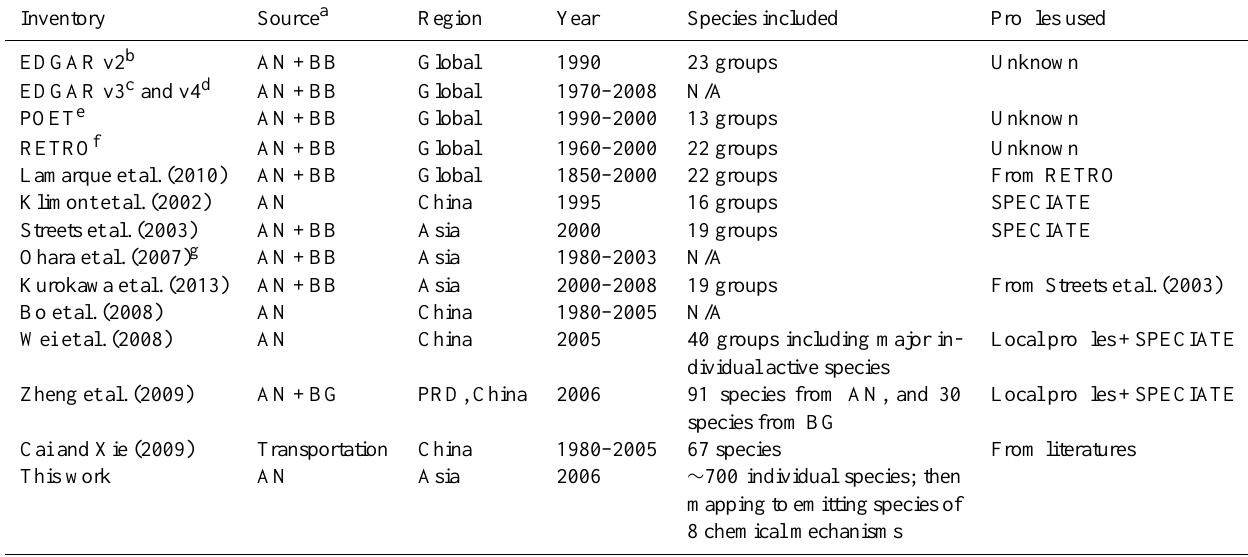
Table 1. NMVOC emission inventories covering Asian